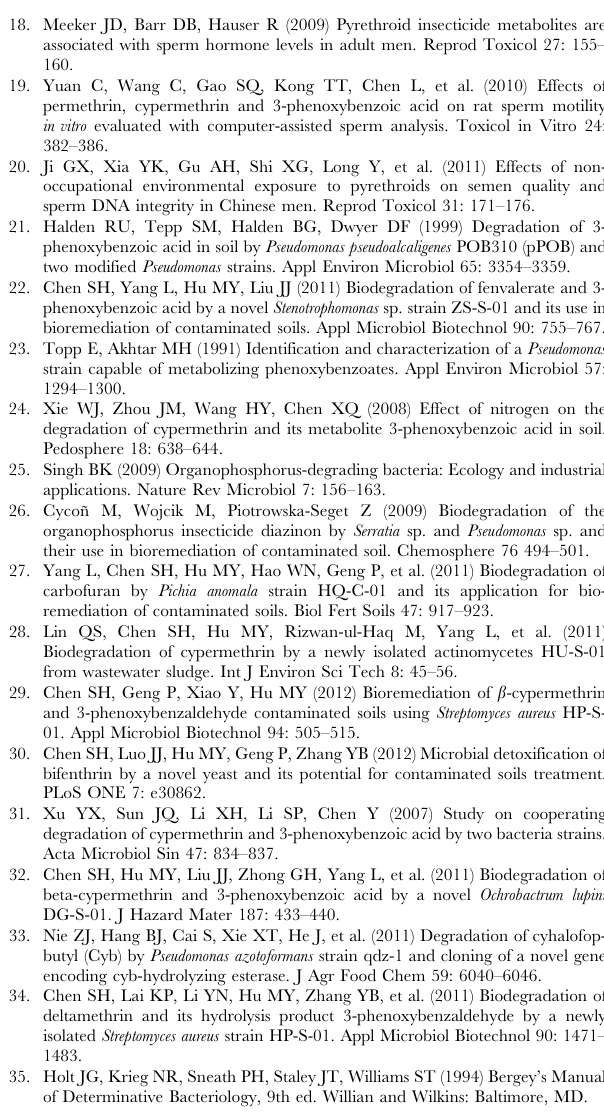
Figure S1 Morphological characteristics of strain DG- 02 under scanning electron microscopy (15,000 6 ). (TIF) Figure S2 GC-MS spectra of metabolites produced from 3-PBA degradation by strain DG-02. a, 3-PBA; b, 3-(2- hydroxyphenoxy) benzoic acid; c, protocatechuate; d, phenol; e, 3,4-dimethoxy phenol.